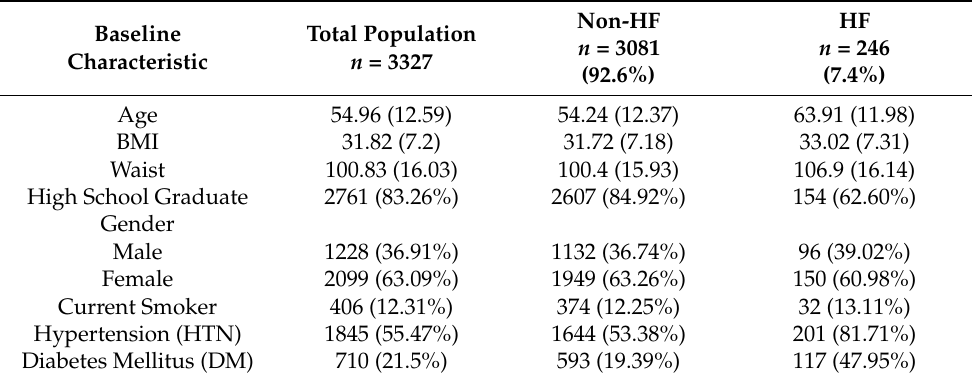
Table 1. Descriptive statistics of the study population.